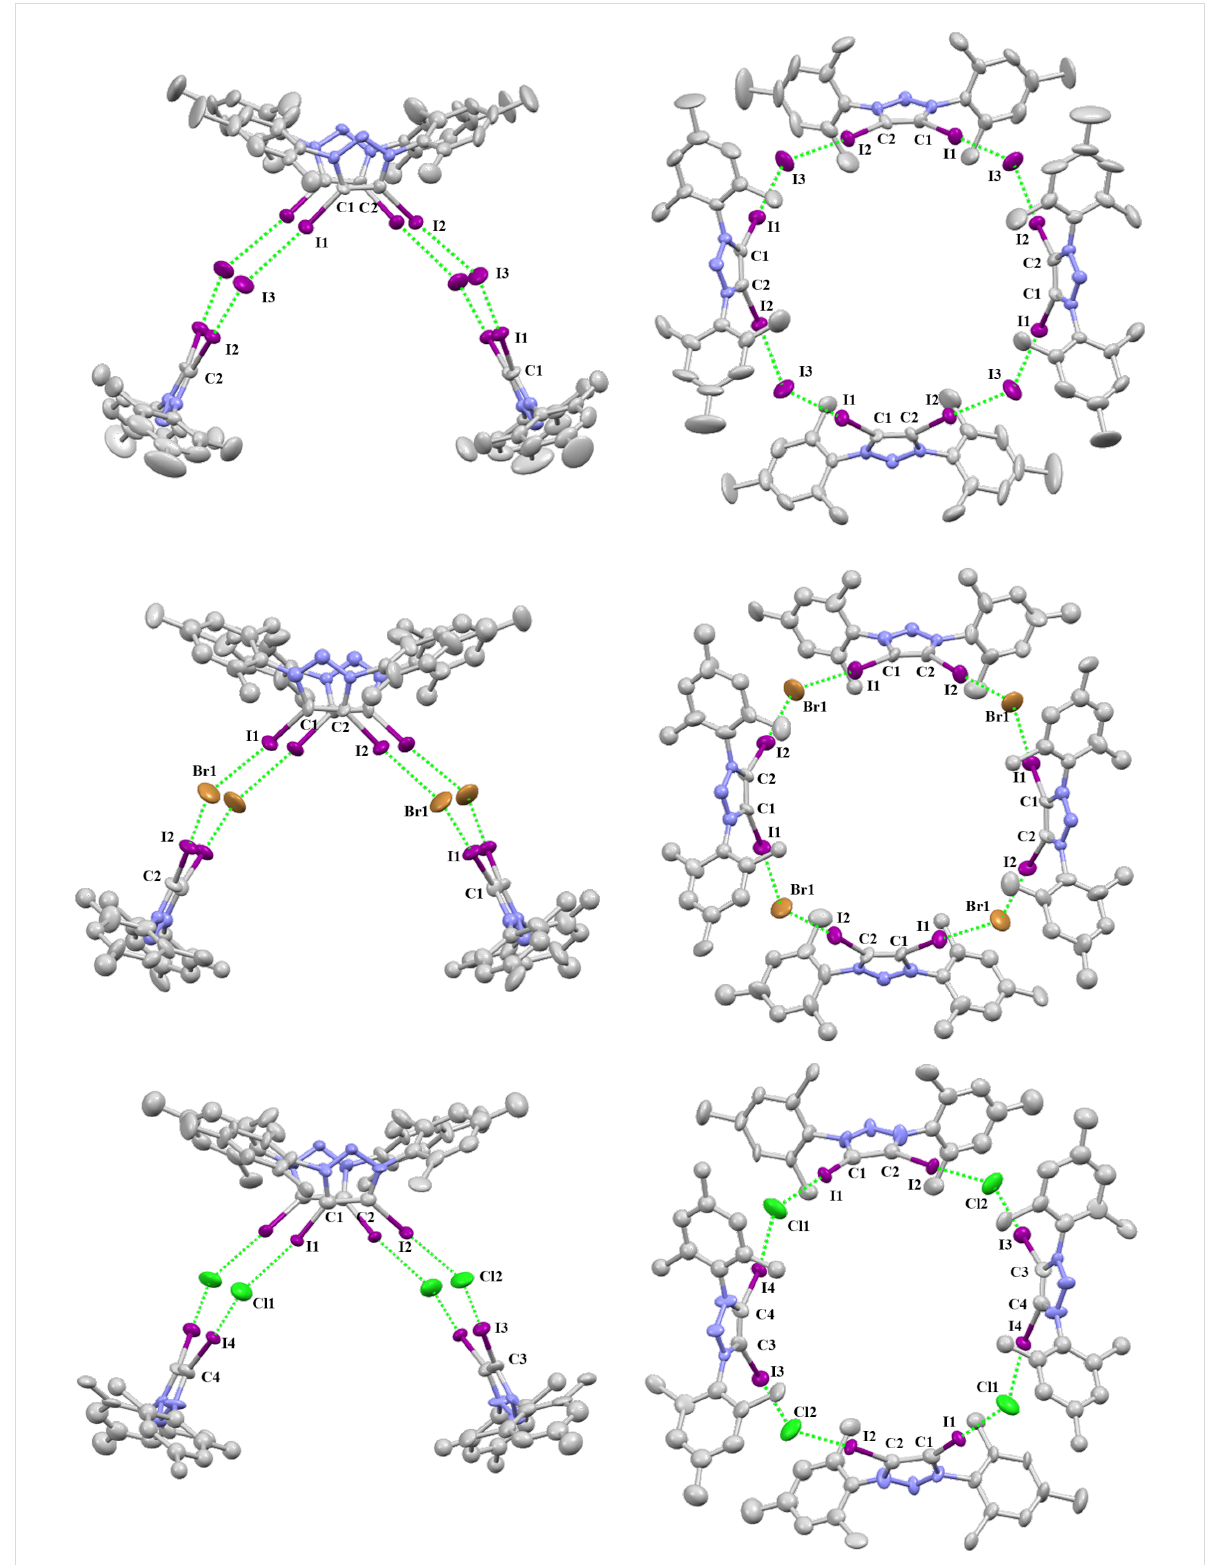
Figure 2: Packing structure of 2-I (top), 2-Br (middle) and 2-Cl (bottom). Hydrogen atoms have been omitted for clarity. Side view (left) and top view